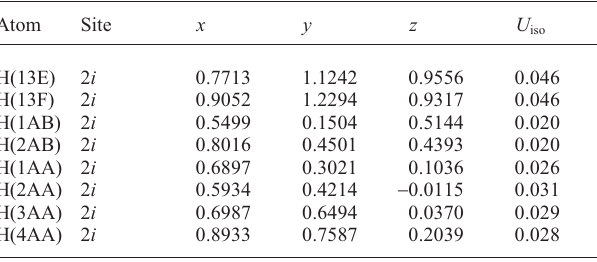
Table 3. Atomic coordinates and displacement parameters (in Å 2 )